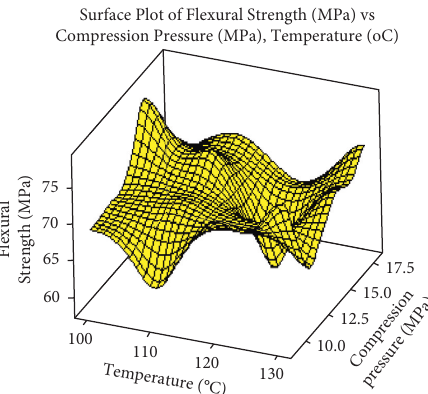
Figure 10: Flexural strength: surface plot of temperature and compression